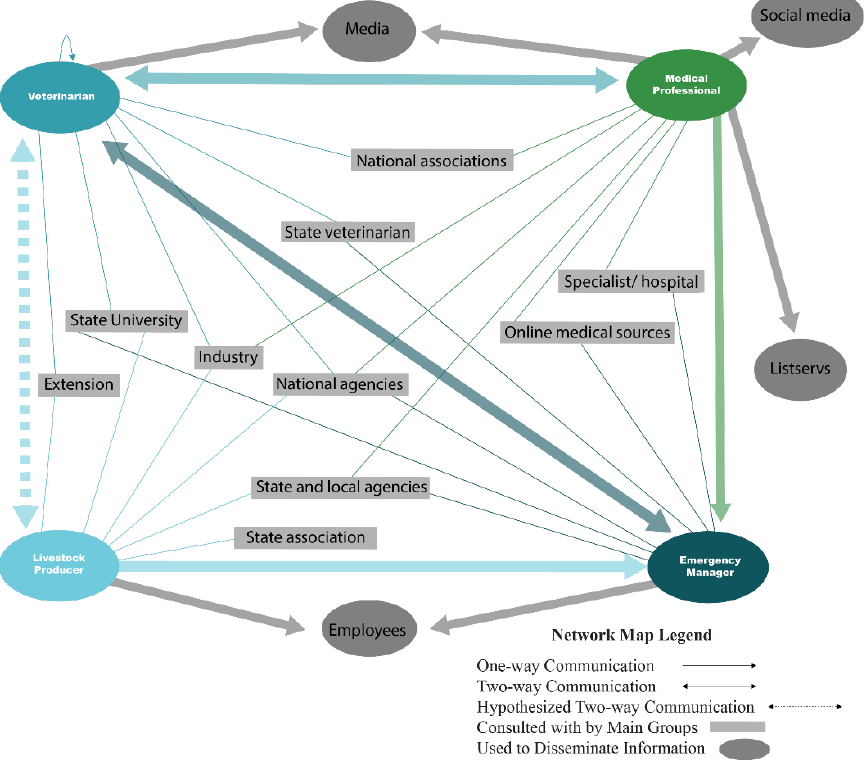
Note. Colored circles indicate the groups interviewed. Grey circles indicate groups the colored circles would share information within an effort to disseminate information in a crisis. Dashed line indicates a hypothesized two-way relationship because previous literature indicates this, even though data in this study only showed a one-way relationship. Rectangles are groups the colored circles would consult with for more information during a